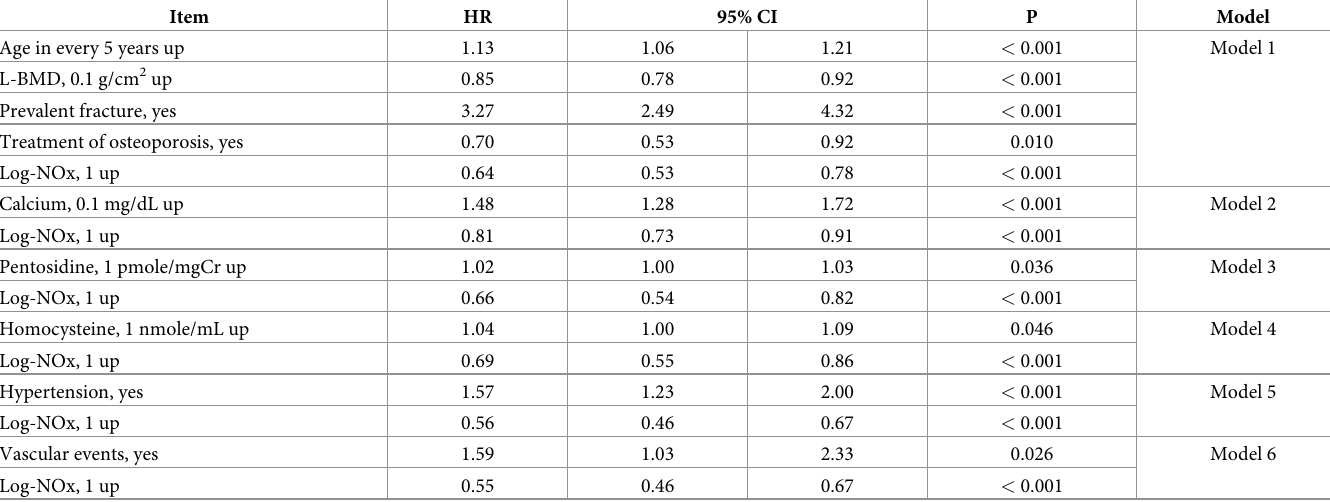
Table 2. Cox proportional hazards model for the association between serum NOx and incident osteoporotic fracture.